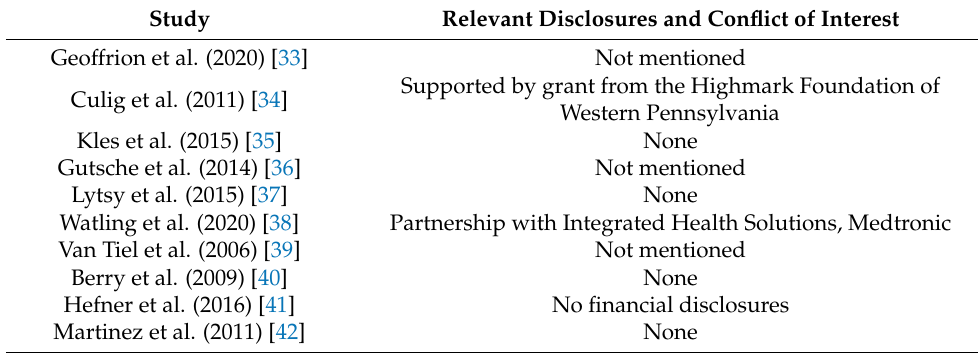
Table 3. Relevant disclosures and conflicts of